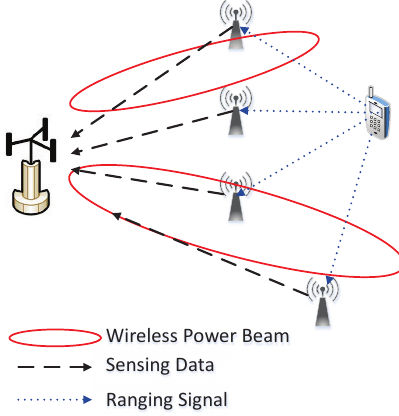
Figure 1. The architecture of